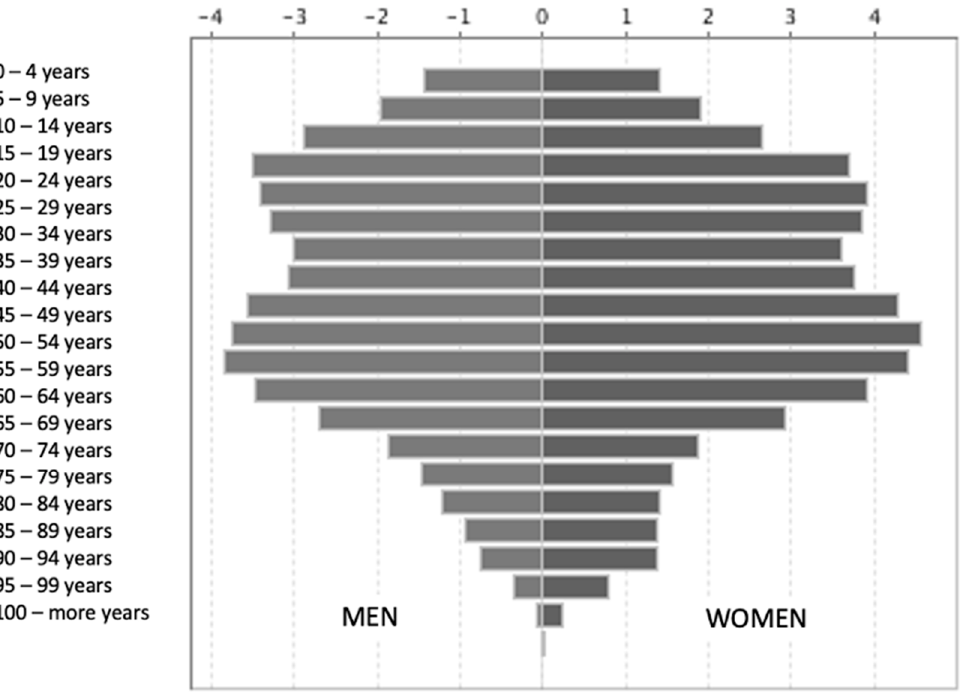
Figure 1. Incidence of COVID-19 in the province of Granada grouped by sex and age. Source: IECA portal on the COVID-19 in Andalusia.